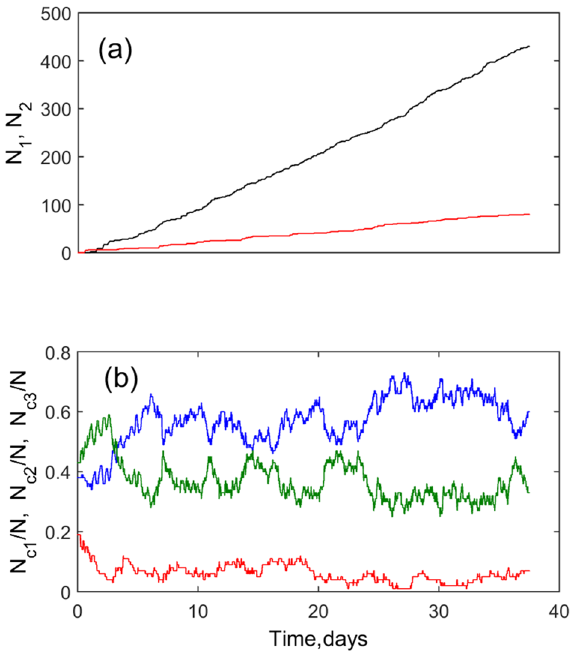
Figure 7. Time depending integral populations: ( a ) accumulated numbers of died ( N 1 ) and survived ( N 2 ) animals (black and red curves); ( b ) variations of the numbers of animals in subpopulations of small ( N c1 ), medium ( N c2 ) and large ( N c3 ) animals shown by blue, green and red curves